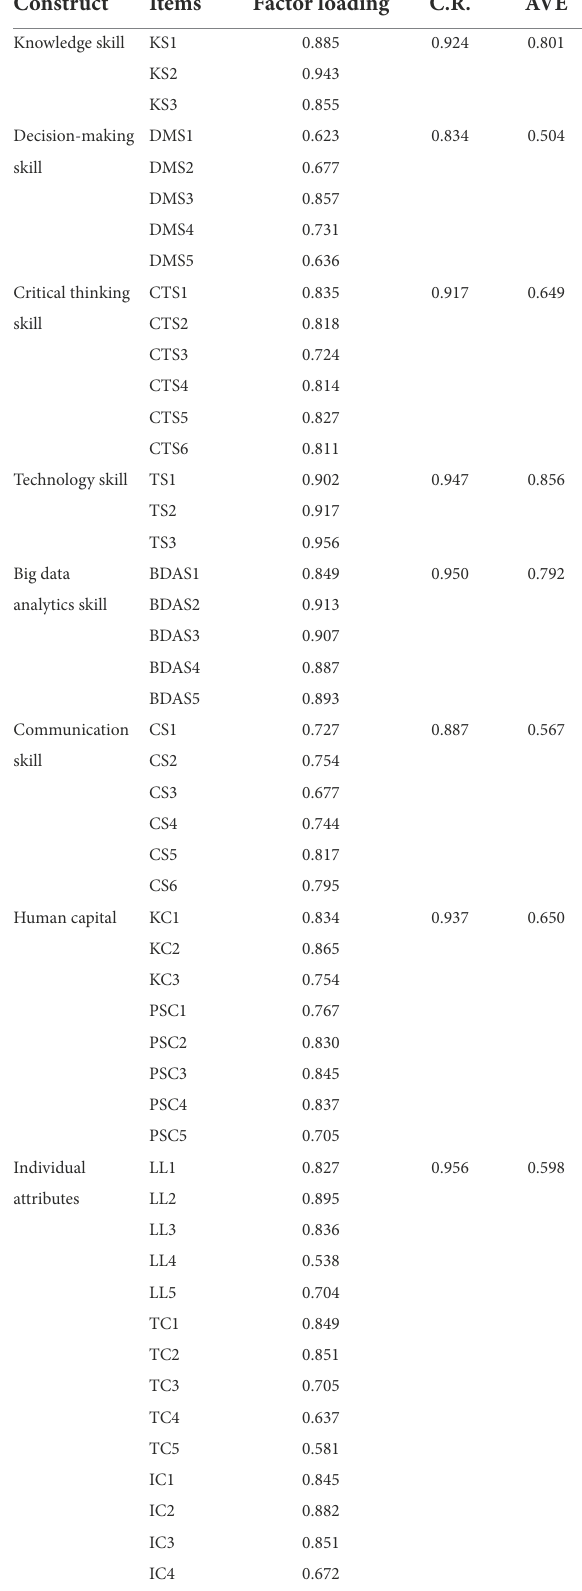
TABLE 4 The results of factor